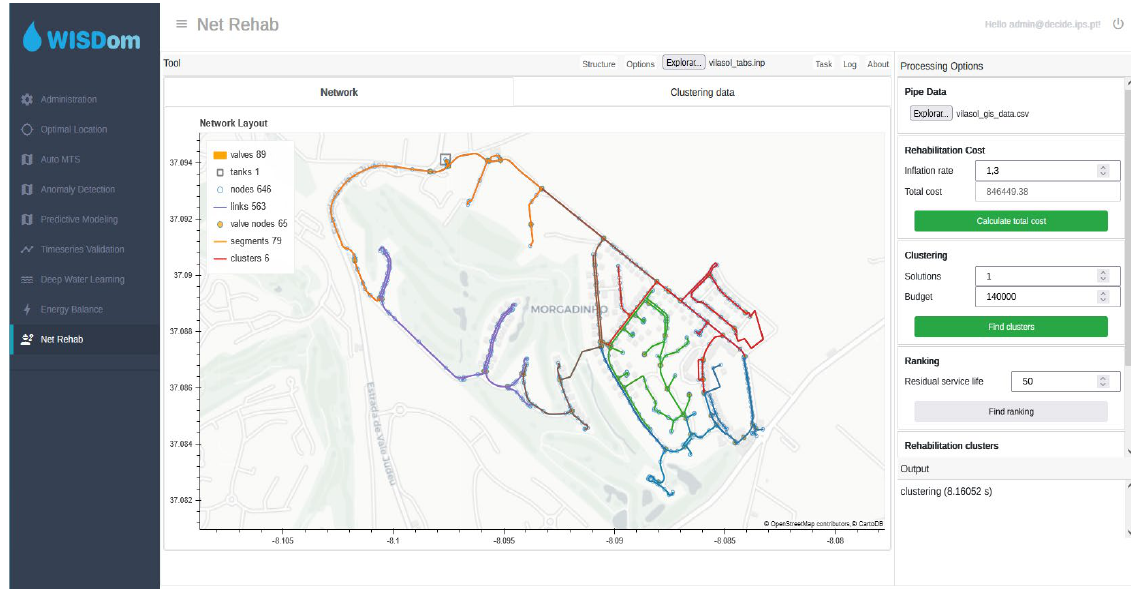
Figure 6. Screenshot of tool for the prioritization of rehabilitation units for interventions.